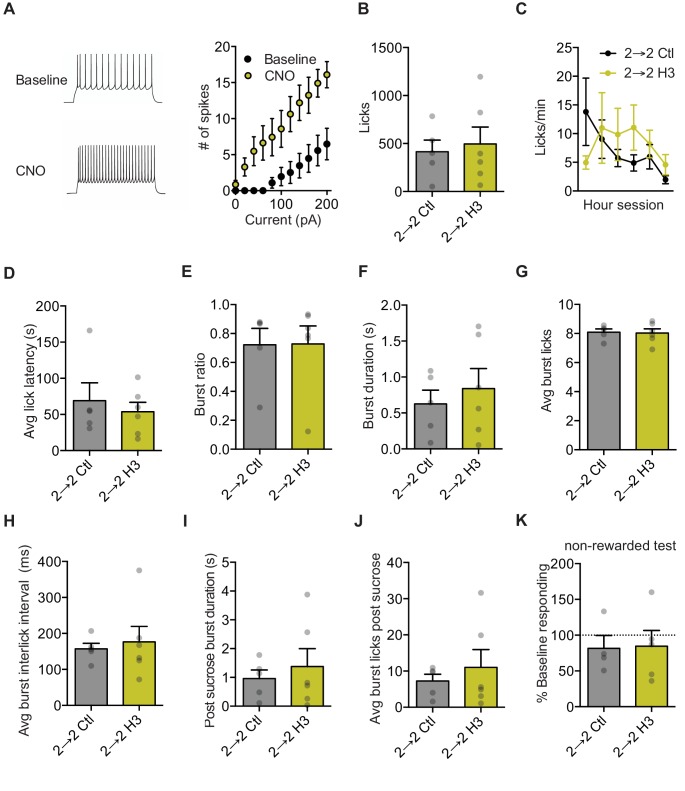
Orbitofrontal cortex excitation does not generate an increased motivational state.(A) Spikes and trace from H3 slice data (cells n = 7). Two-way repeated measures ANOVA: interaction of Current x Treatment: F(10,60) = 2.94; Main effect of Treatment: F(1,6) = 23.09, p=0.003; main effect of current: F(10,60) = 29.63, p<0.0001. (B) Total licks during RT session. (Group n’s: (2→ 2 Ctl: 5), (2→ 2 H3: 6)) (C) Licking rate in 10 min bins over the 60 min re-exposure session. (D) Licks occurring in bursts over total licks. (E) Average burst duration. (F) Average number of licks within a burst (G) Average latency to begin licking after sucrose deliveries. (H). Average interlick interval within bursts. (I) Average burst duration after sucrose deliveries. (J) Average number of licks within a burst after an outcome delivery. (K) Percent of baseline responding during non-rewarded test. Data points and bar graphs represent the mean ±SEM. * indicates p<0.05. All t-tests for licking data and non-rewarded test day: p>0.05.